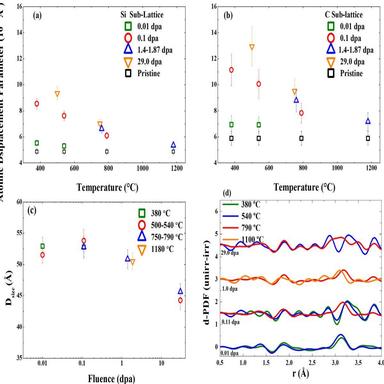
Structural parameters (a) Si sub-lattice and (b) C sub-lattice atomic displacement parameters, (c) particle size determined from the PDF fitting; (d) differential-PDF patterns for irradiated specimens. Specimens are grouped together with similar irradiation dose, and vertically offset for clarity for the pristine and irradiated samples. Data was modified from .